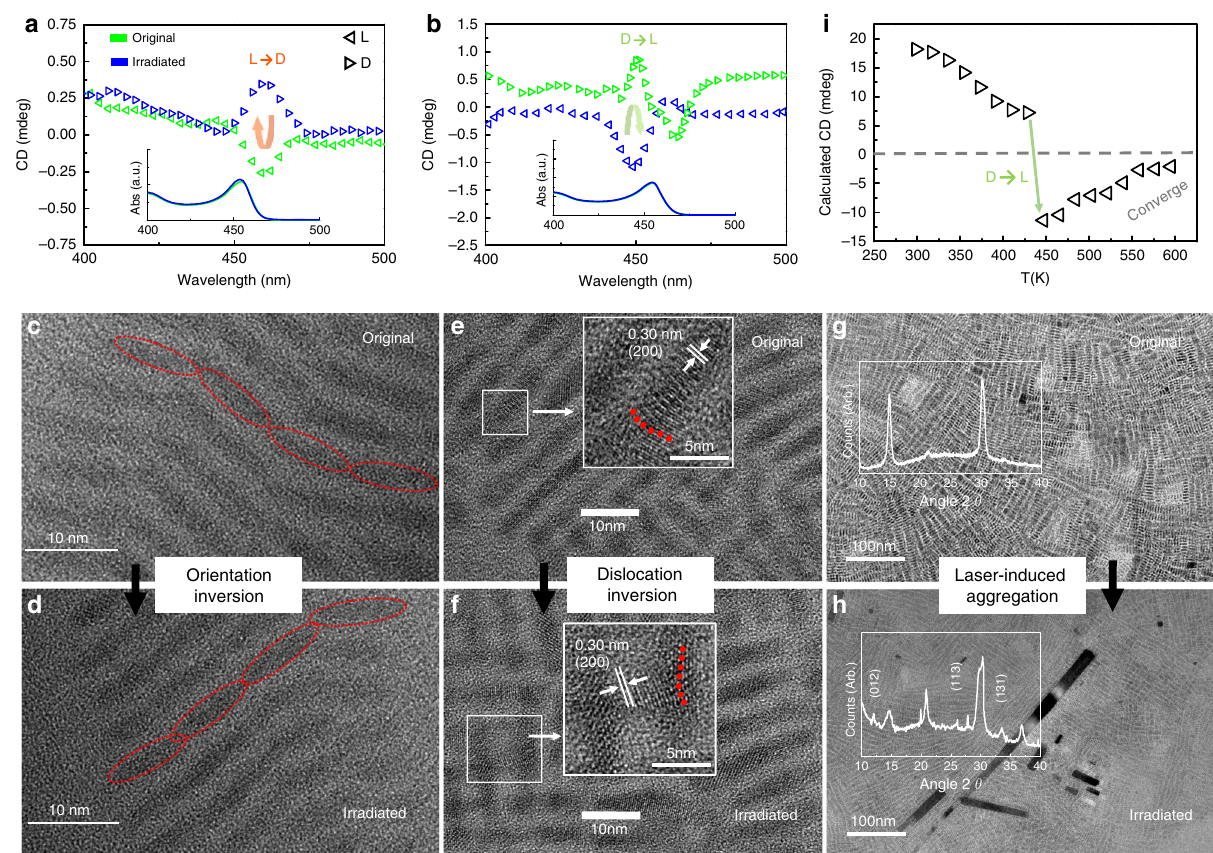
Fig. 4 Investigation of the laser-induced chirality inversion of IPNCs. Laser-induced chirality inversion was achieved both in a the local optimal sample (from L to R) and b the global optimal sample (from R to L). An inversion of orientation was observed by comparing the TEM image of c the original local optimal sample and d that after laser heating. Evidence of dislocation inversion is also captured in the HRTEM image of e the global optimal sample and f the sample after irradiation. g , h Aggregation occurred after laser treatment. The XRD patterns were inserted for comparison. i Numerical data with the parameters observed from the